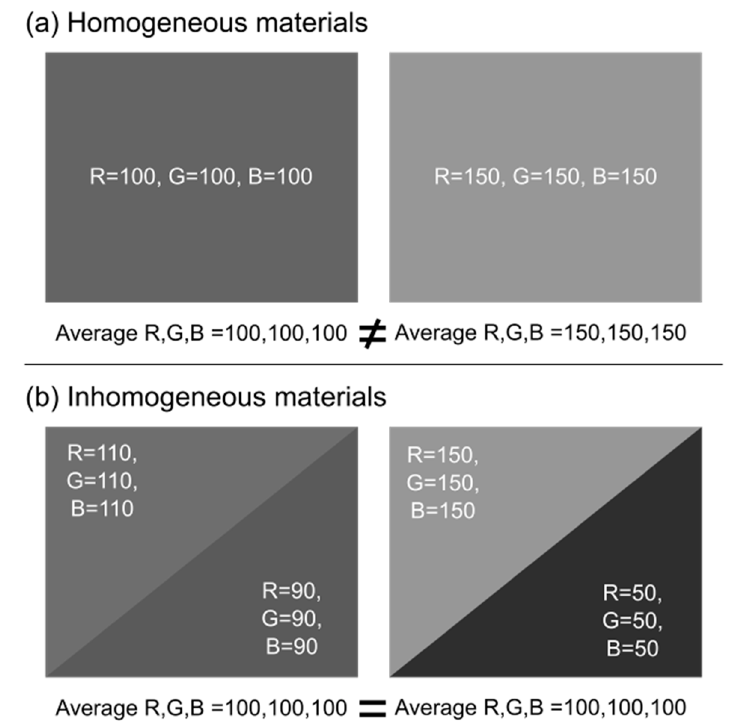
Figure A11. Schematics illustrating ( a ) homogeneous and ( b ) inhomogeneous materials and their associated average colours. For materials as described in ( b ), the average CaliPhoto colour cannot be used in the database since these different samples are associated with identical average values.